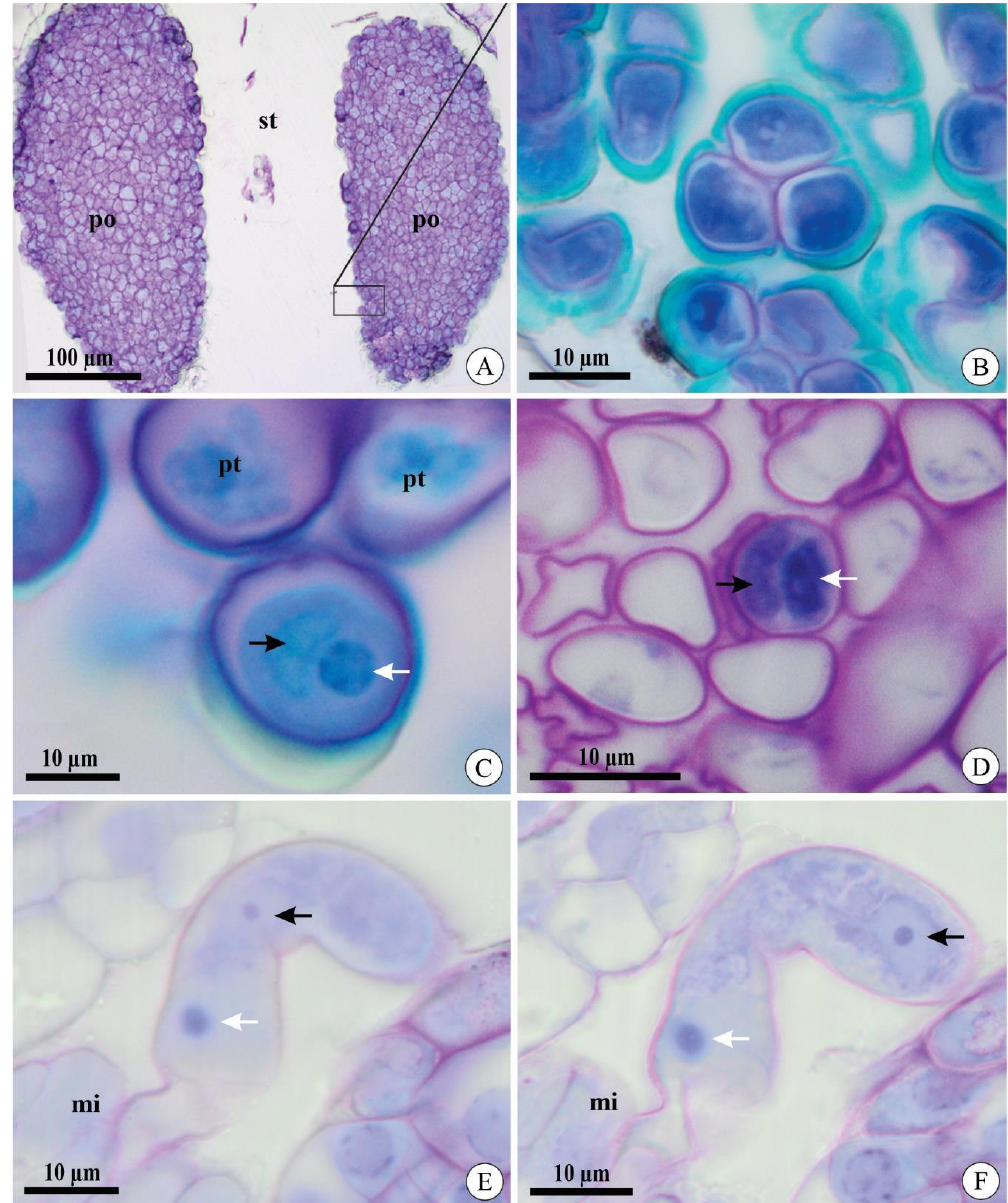
Figure 1. Pollinia and pollen tubes of Acianthera johannensis ( A , B , E , F ) and A. fabiobarrosii ( C , D ) under light microscopy, in transverse ( A – D ) and longitudinal ( E , F ) sections. ( A ) Two pollinia in the stigmatic cavity. ( B ) Pollen grain in tetrads. ( C ) Pollen grain after cross-pollination. Notice the generative cell (black arrow) and the nucleus of the vegetative cell (white arrow). ( D ) Pollen tubes after cross-pollination in the ovary 27 days after pollination (DAP). Notice the two cells in the microgametophyte, a generative cell (black arrow), and the nucleus of the vegetative cell (white arrow). ( E , F ) Pollen tube in the micropyle 40 DAP in two sequential focus planes. Notice the nucleus of the vegetative cell in both figures (white arrow) and two sperm cells (black arrows), with one visible in each figure. mi, micropyle. po, pollinia. pt, pollen tube. st, stigmatic cavity. In both species, the pollen grains deposited in the stigmatic cavity germinated with approximately three days after pollination (DAP) and started to grow along the stylar canal inside the column (Figure 2A). These pollen tubes had synchronized growth, that is, they grew together